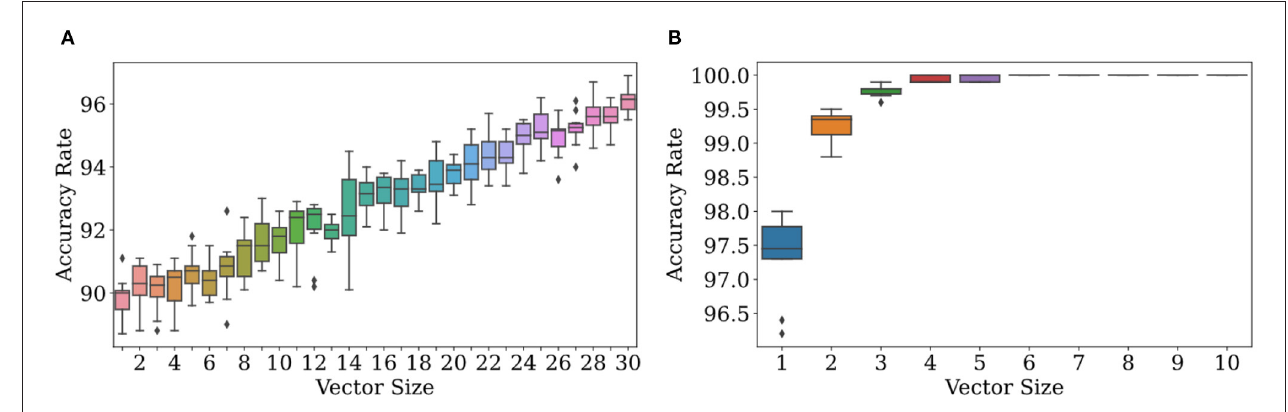
N (200,2), φ f N (201,2), and f 1. At (A) , φ r 0.1. Due to the similarity of ≥ = = = N (200,2), φ f N (201,20), and f 0.1. Due to the high variance in φ f and thus dissimilarity in the = = =